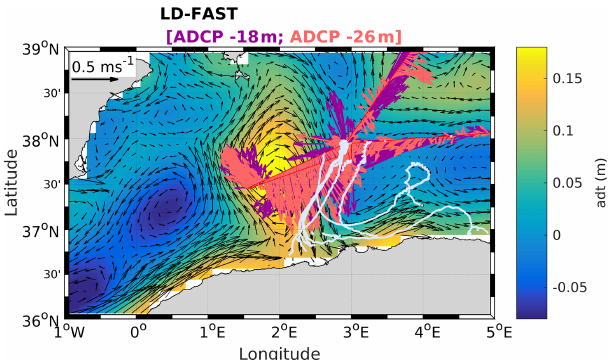
Figure 11. Geostrophic currents from satellite data with the Ekman component from the WRF model added (black arrows, mean for the shown transect). In addition, in situ drifter trajectories during 30d (launched at FAST and in its vicinity) are represented as white lines. Horizontal currents measured by the VM-ADCP for the first two bins (purple arrows − 18m; salmon arrows − 26m) are super- imposed for